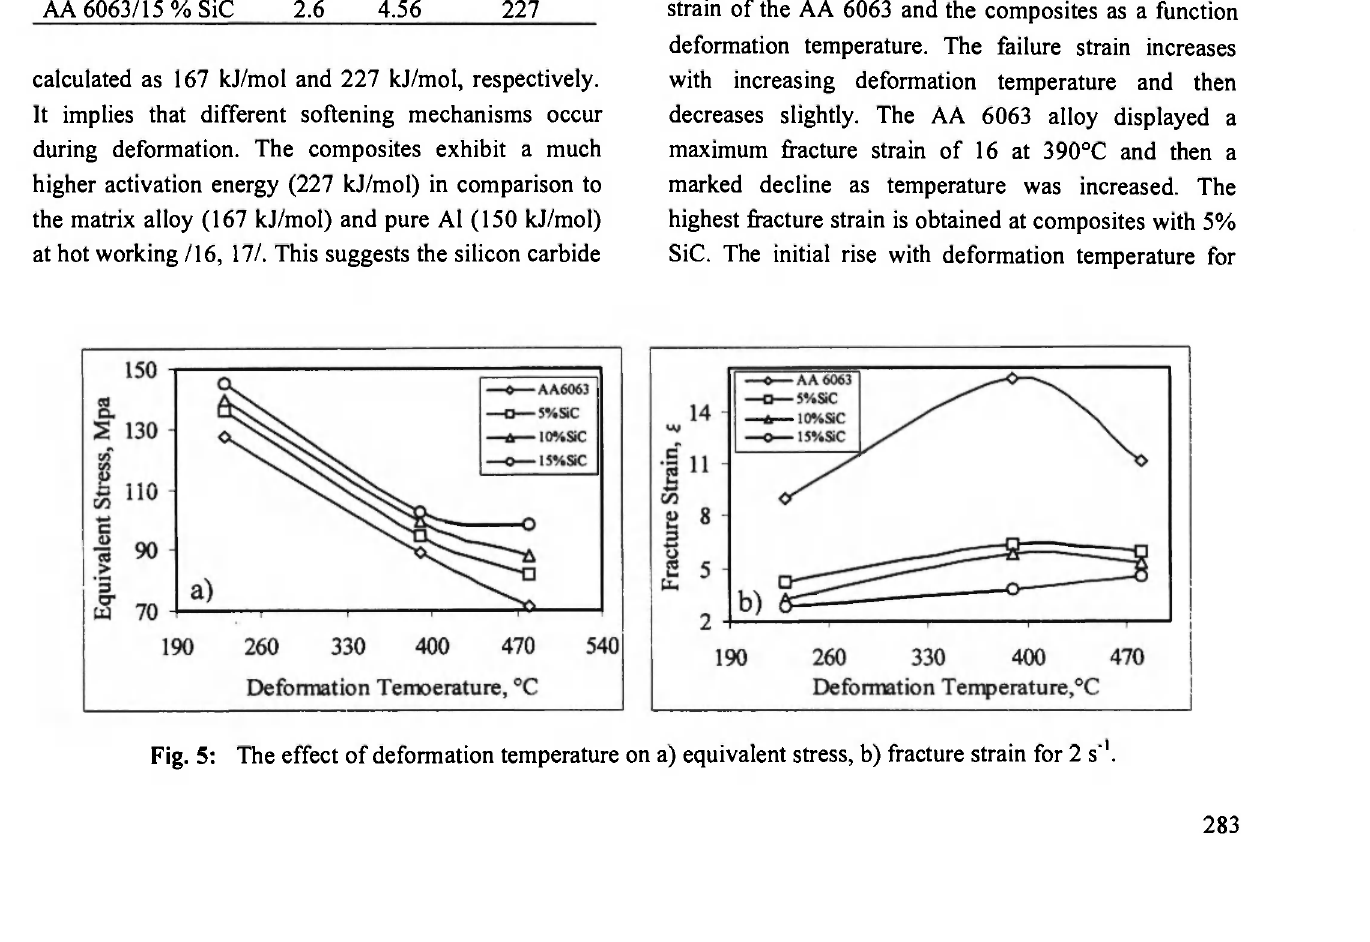
Summary of stress exponents (n), slopes (s) and activation energies (Q) for AA 60063 and composites.